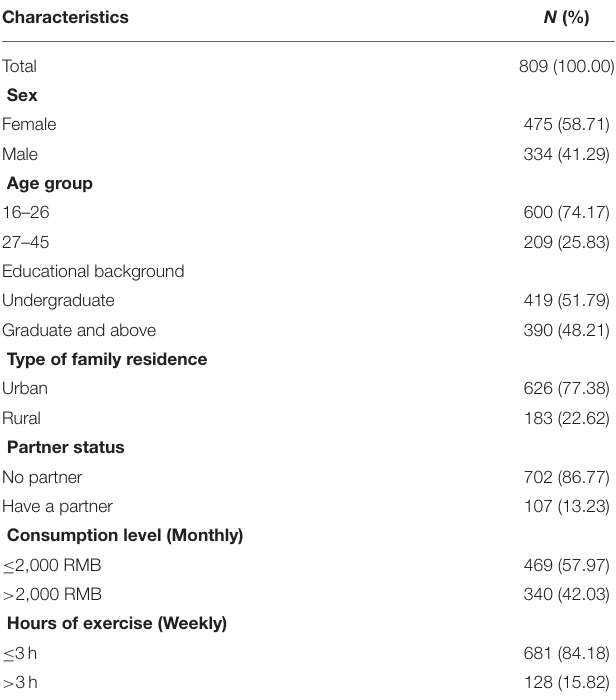
TABLE 1 | Demographic characteristics of